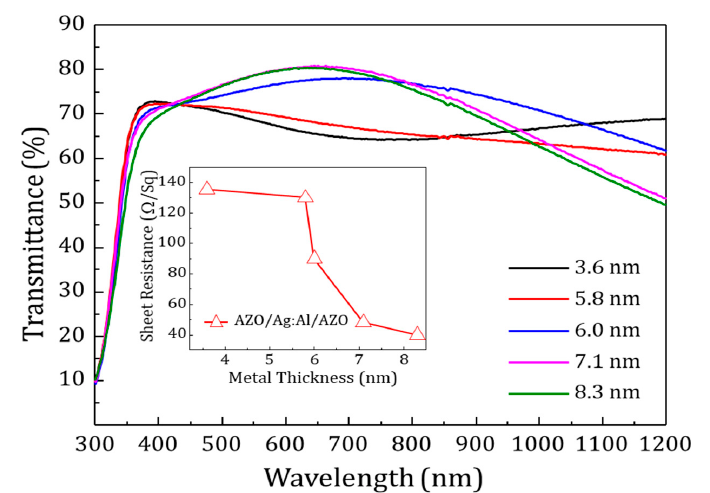
Figure 8. Optical transmittance of AZO / Ag:Al / AZO (18 nm / Ag:Al / 70 nm) multilayer structure deposited on glass is shown. Inset shows the sheet resistance as a function of metal thickness. Optical combination of high transparency and lower sheet resistance was obtained for the metal thickness of 7.1 nm.